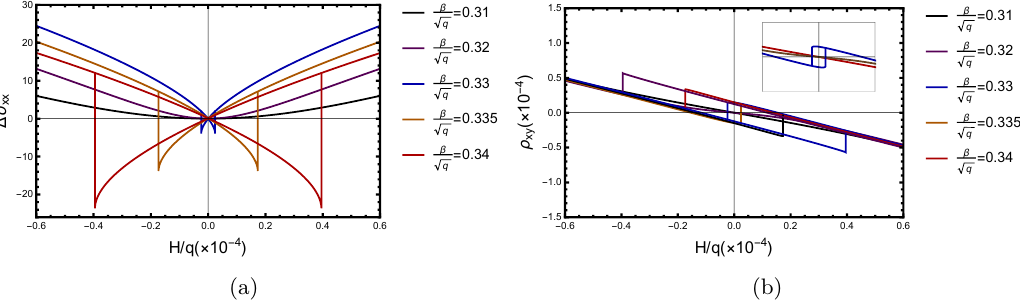
√ q = 3 × 10 − 4 . . These are very similar H =0